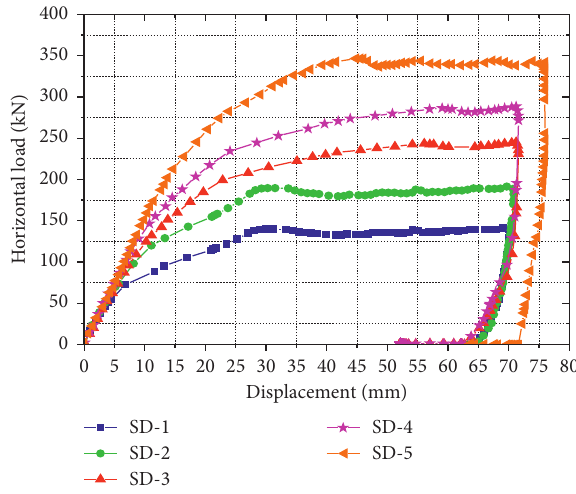
Figure 14: Curve of load displacement under monotonic